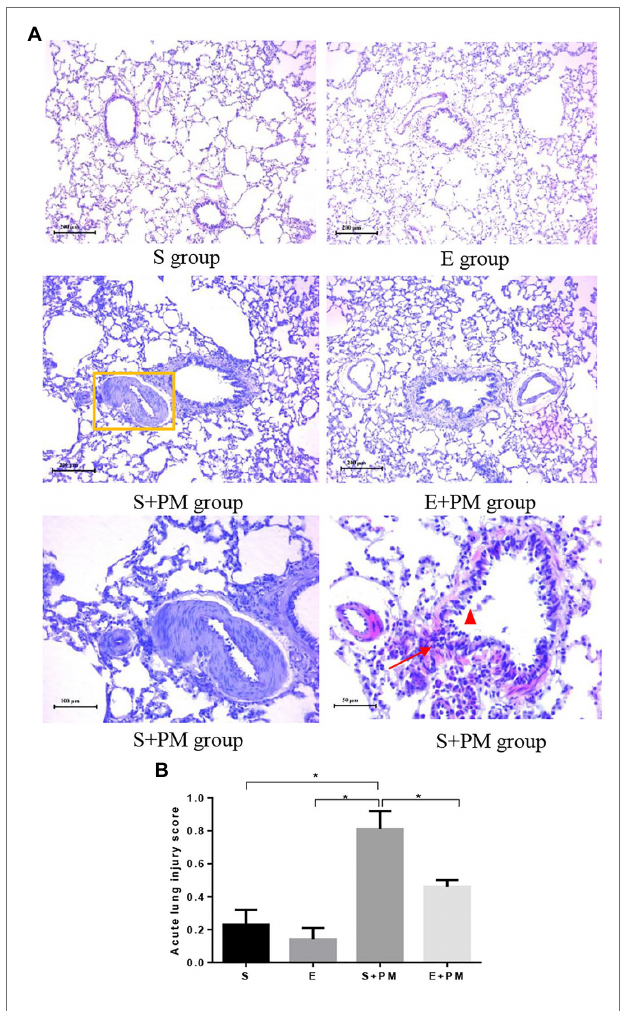
FIGURE 3 | Photomicrographs of rat lung (HE stain) in different groups. (A) Histologic analysis of lung tissues. Yellow rectangle indicated pulmonary artery; red triangle indicated mucous membrane exfoliation; red arrows indicated inflammatory infiltration. (B) Acute lung injury scores in different groups. Data represent mean ± SD. * p < 0.05 between groups.